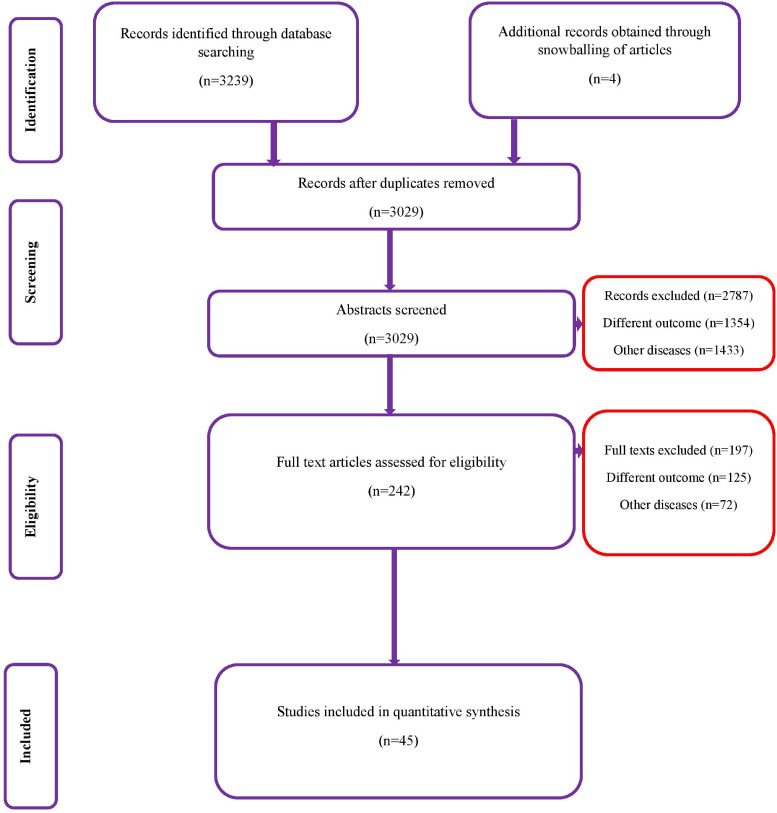
PRISMA flowchart.